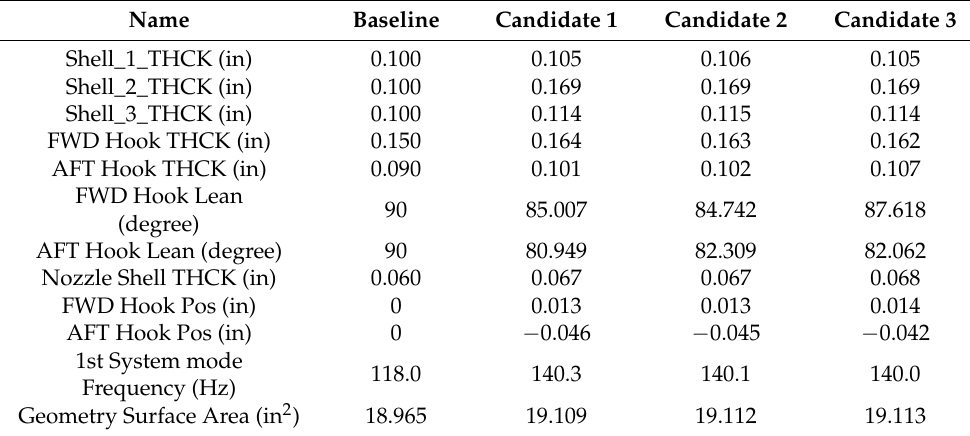
Table 5. Optimization results—Objective function J 1 .